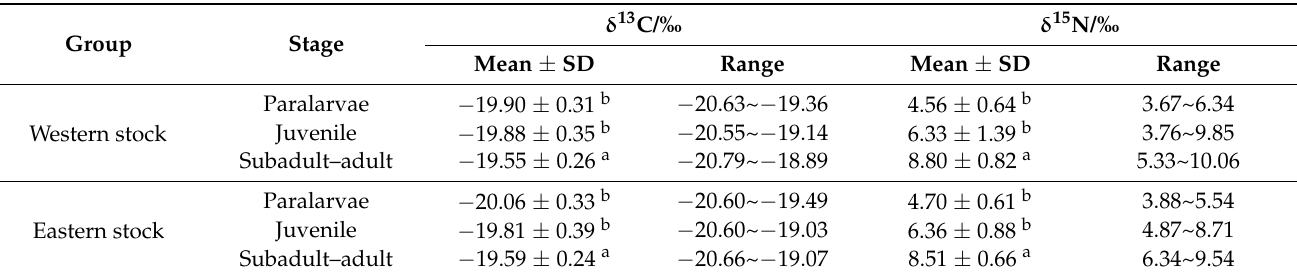
Table 4. Stable isotope concentrations of neon flying squid eye lenses from the eastern and western stock populations (multiple comparisons by letters (a,b) to show significant differences ( p < 0.05). SD represents standard deviation).